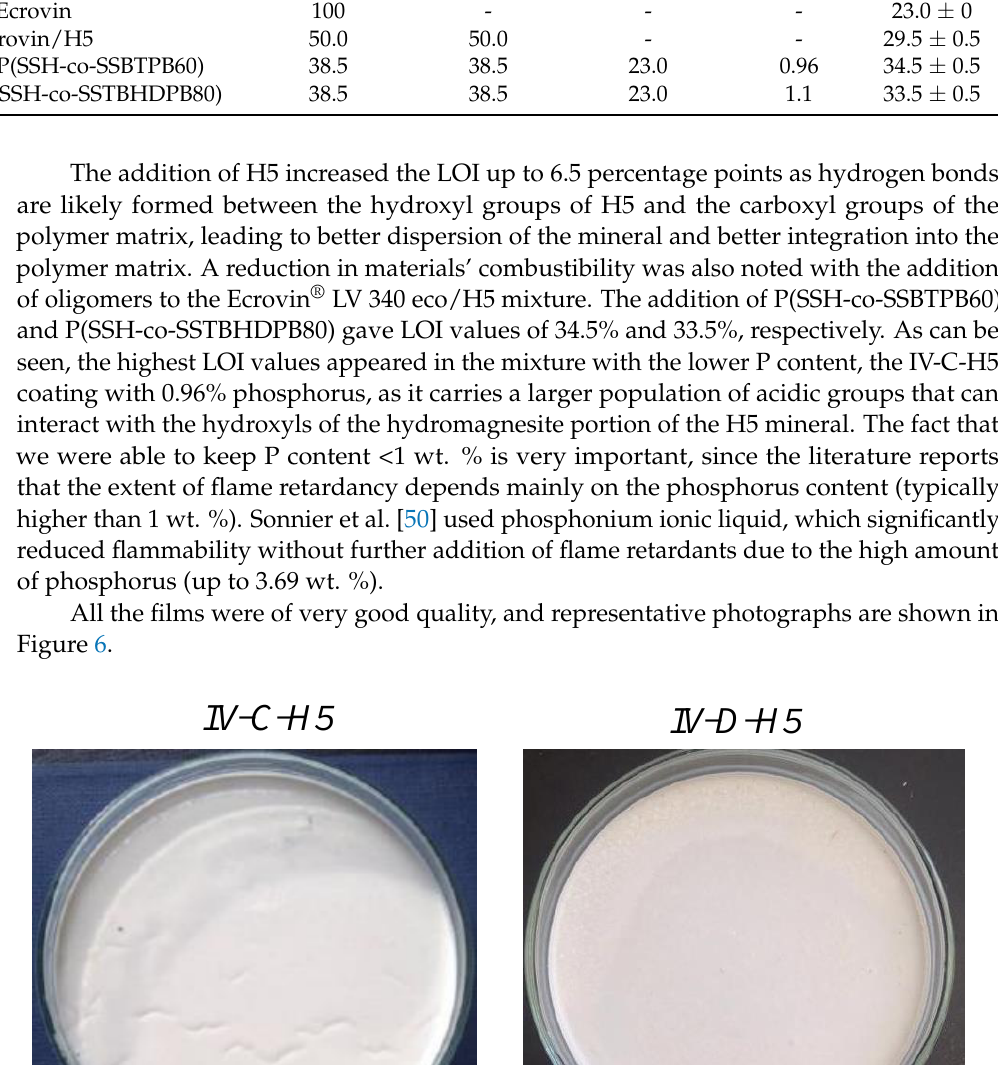
Table 8. LOI measurements of Ecrovin ® LV 340 eco blends with H5 and additives.